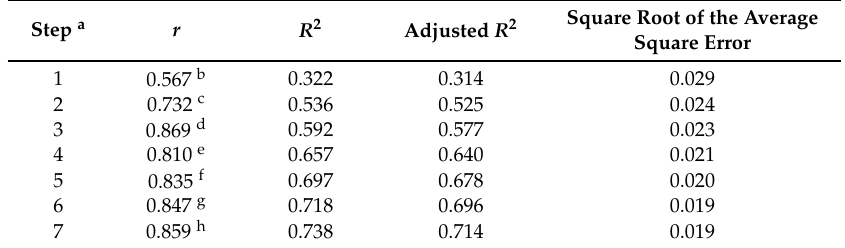
Table 4. Summary of Model 1 to estimate the thermal conductivity of aerogel-based renders.